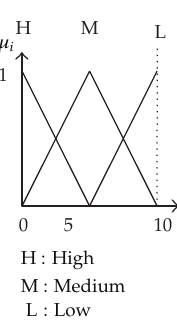
Figure 4: The membership function for